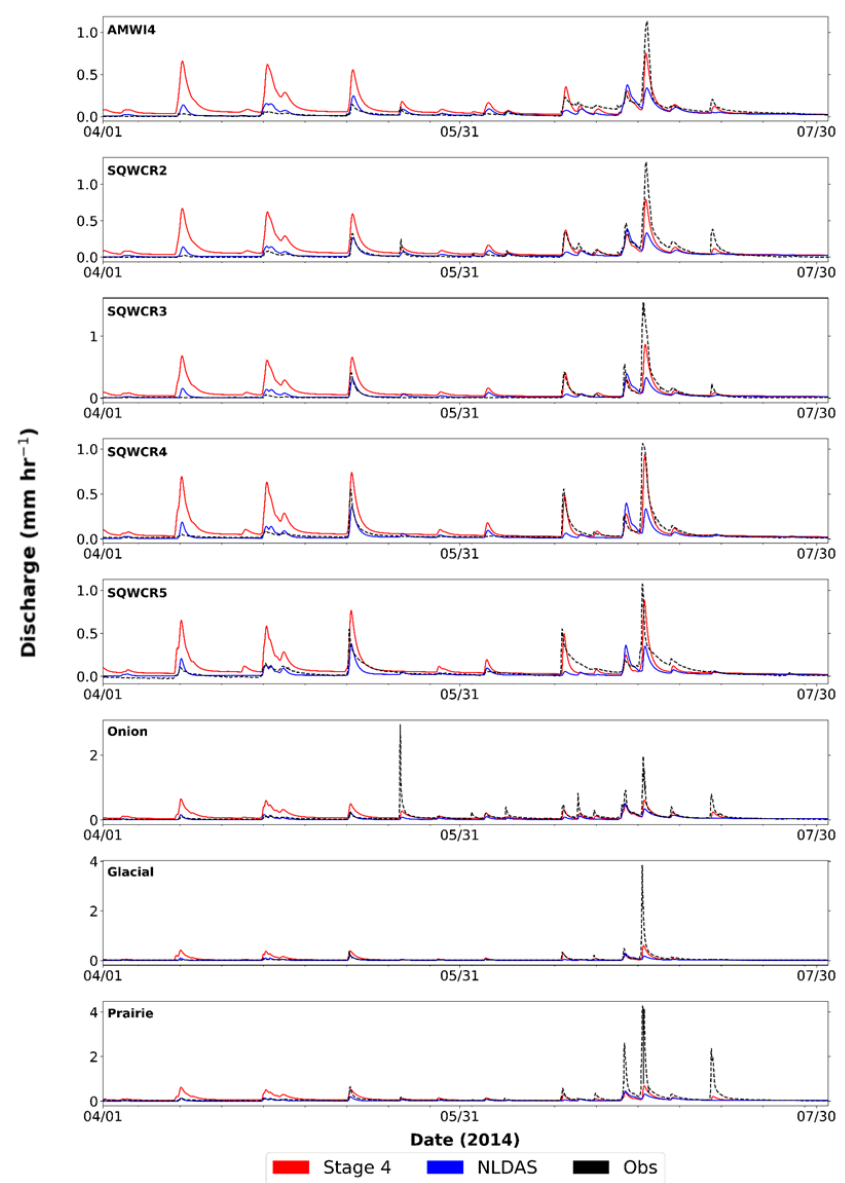
Figure 6. Simulated and observed discharge for the Squaw Creek watershed for the period of 1 April 2014 to 31 July 2014. SQWCR.